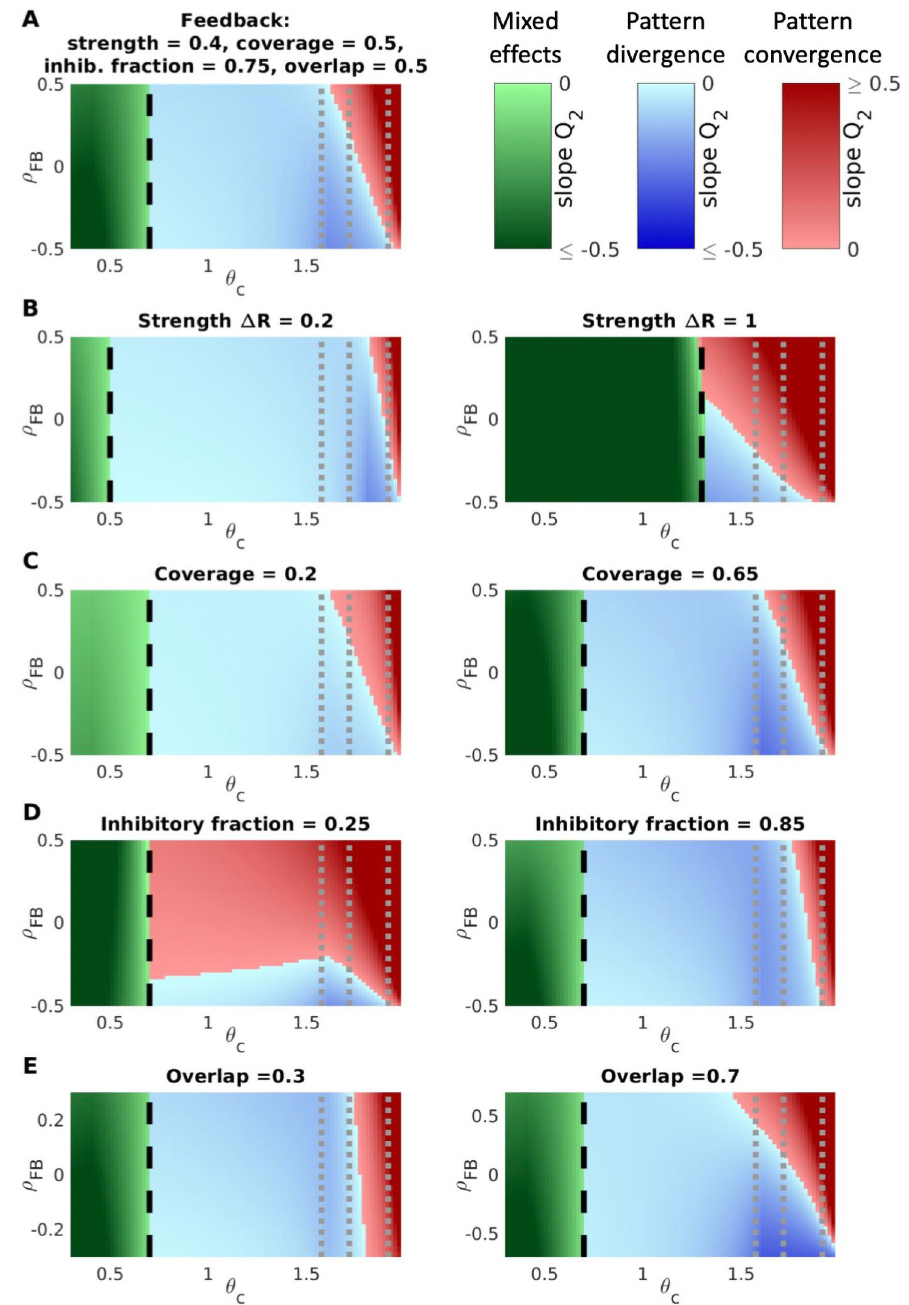
Fig 3. Pattern convergence and divergence for general feedback. ( A ) We computed the slope in Eq 7 as a function of the cortical threshold θ and the feedback similarity ρ for the following set of plausible feedback conditions: 1) c FB feedback strength Δ R = R max /5; 2) feedback coverage p + + p − = 0.5 for both odors; 3) fraction of feedback-affected modules that receive inhibitory feedback for one of the odors p /( p + + p ) = 0.75 (the inhibitory fraction for the other − − odor varies with the feedback correlation along the y-axis); overlap between the subsets of modules affected by the feedback for the two odors p both = 0.5. Pattern convergence and divergence increasing with initial odor similarity arise at values of the cortical threshold overlapping with the realistic range, with correlated and anticorrelated feedback, respectively. ( B – E ) Results generalize to a range of feedback conditions. Panels show effects of changing one feedback parameter, while maintaining others as in (A). Color maps represent values of slope coefficient Q 2 from Eq 7, with darker shades corresponding to higher | Q 2 |, as a function of cortical activation threshold θ c and feedback similarity ρ FB